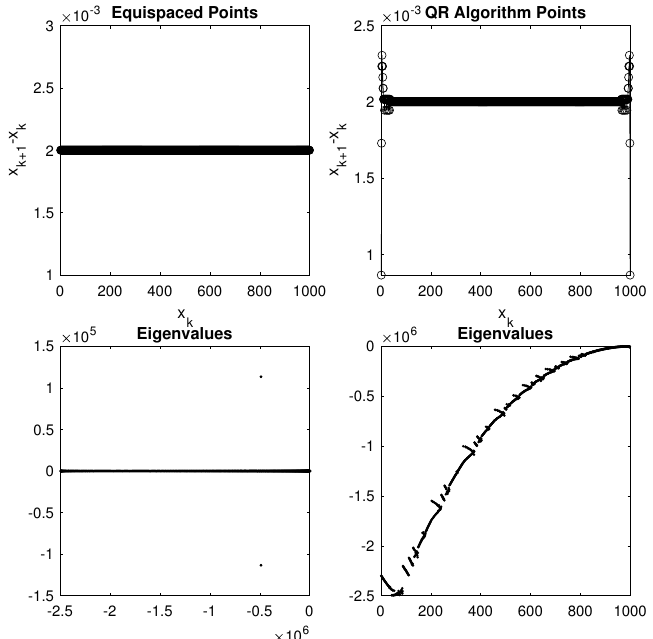
Figure 9. MCpQR algorithm point spacing and Dirichlet Laplacian eigenvalues compared to equis- paced points. In this case, the majority of the points are